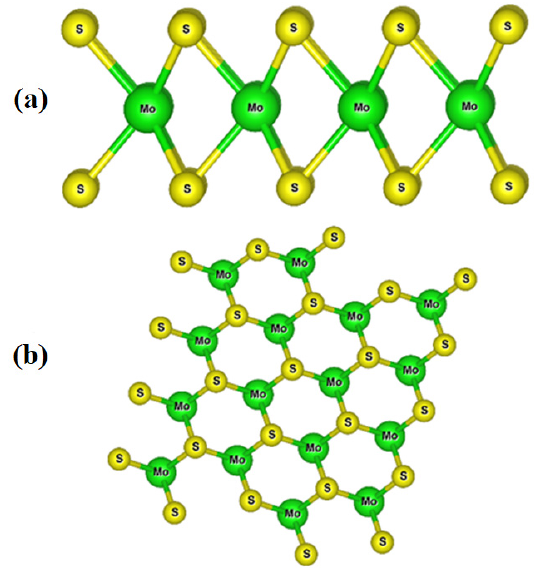
Figure 1. ( a ) Side and ( b ) top views of MoS 2 single